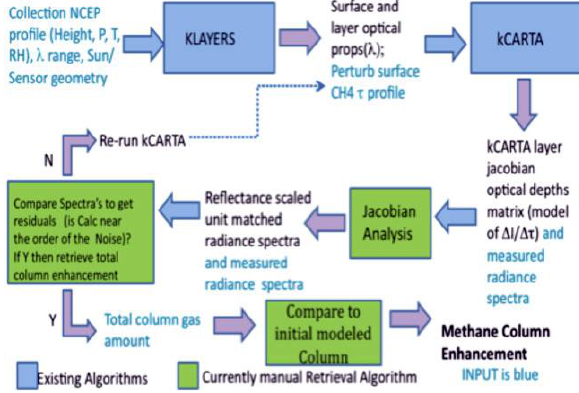
Figure 7. Lockheed Martin Methane Retrieval Processing Diagram